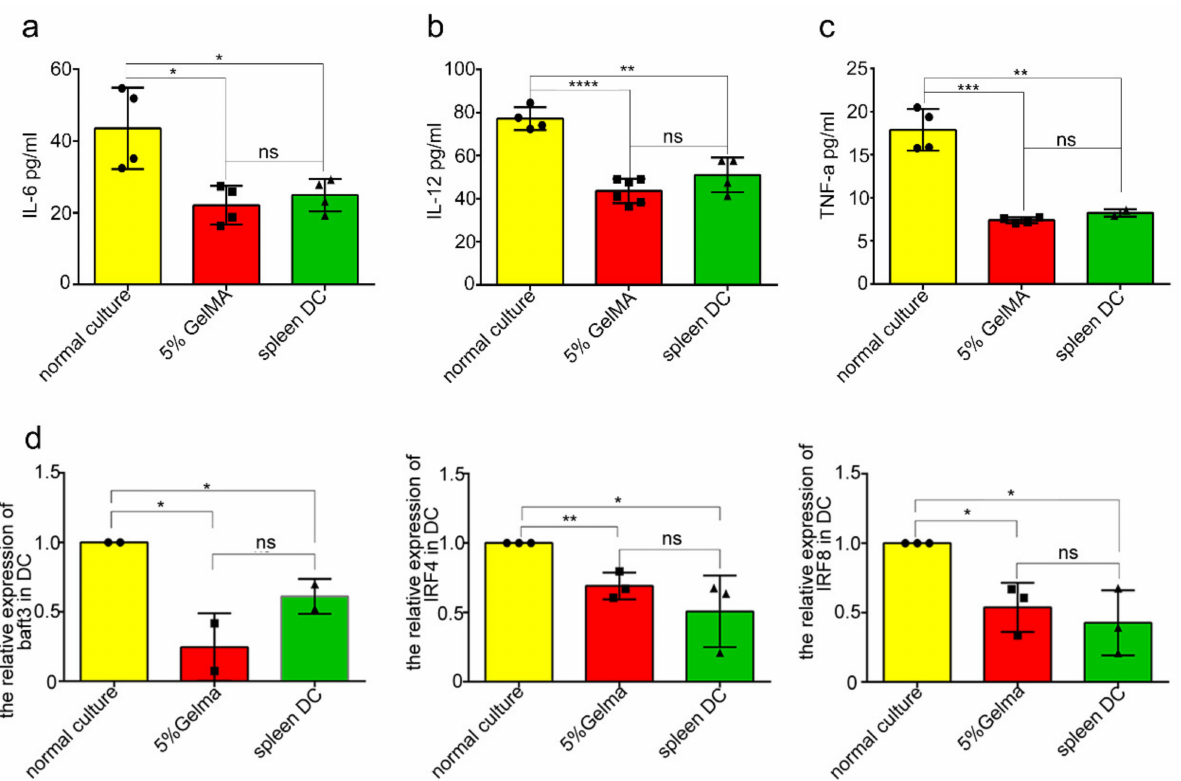
Figure 8. BMDCs cultured on 5% GelMA-30 were closer to the spleen DCs on developmental state. ( a – c ) BMDCs from different culture systems and spleen DCs cultured in the 24-hole plate. Then, culture supernatants were collected 24 h, and cytokine (IL-6, IL-12, TNF-a) levels were measured using ELISA. ( d ) The relative expression of IRF4, IRF8, baft3, and Notch2 of DCs from different culture systems and spleen DCs were measured by qPCR. Data points are represented as mean ± SD for triplicate measurements. These experiments were repeated twice with essentially the same results. In all experiments, each picture was collected as means ± SEM, data were analyzed with unpaired student’s t test or analysis variance (ANOVA) and multiple comparison, and * p < 0.05, ** p <